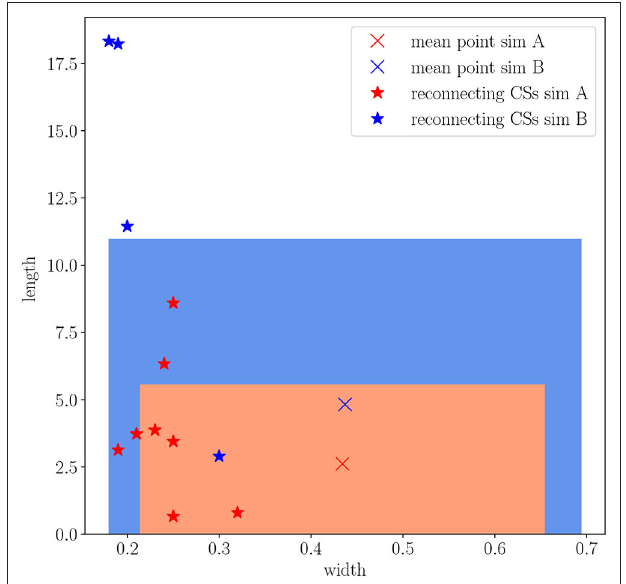
FIGURE 8 | A visual representation of the statistical distribution of width and length of all the CSs present in sim.A (red) and sim.B (blue): the cross indicates the average values and the shaded area the parameter region within one standard deviation. The widths and lengths of selected CSs that exhibit an X point and are clearly reconnecting are indicated by the